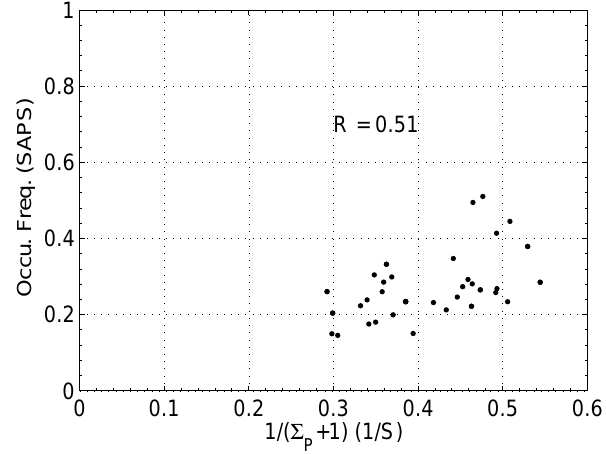
Fig. 7. Correlation analysis of the occurrence of SAPS versus iono- spheric